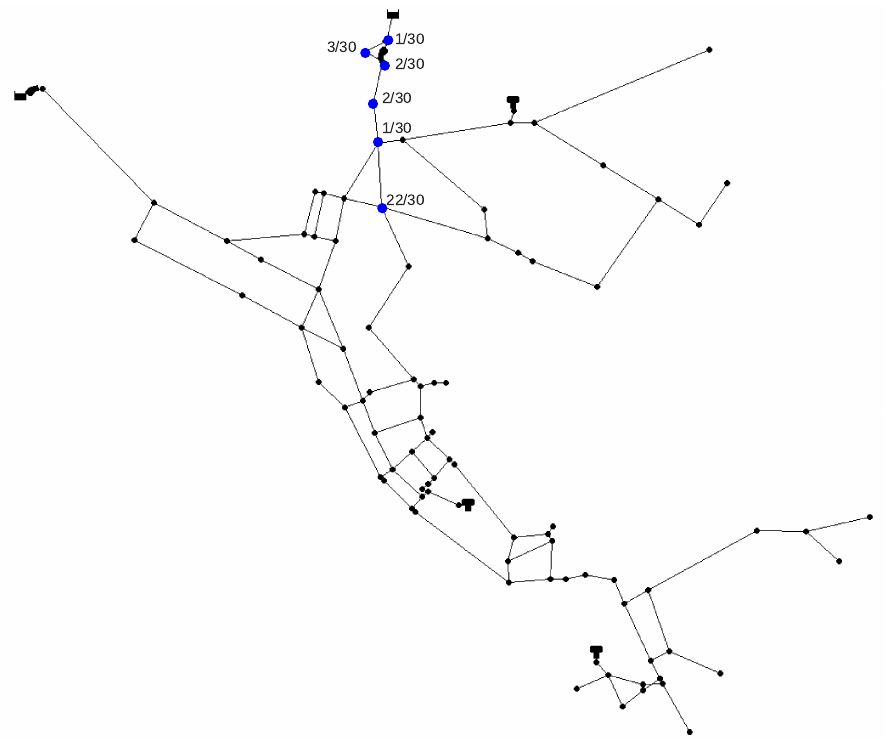
Figure 8. Number of times out of 30 runs for which a node (marked blue) was ranked as first for the Net3 contamination